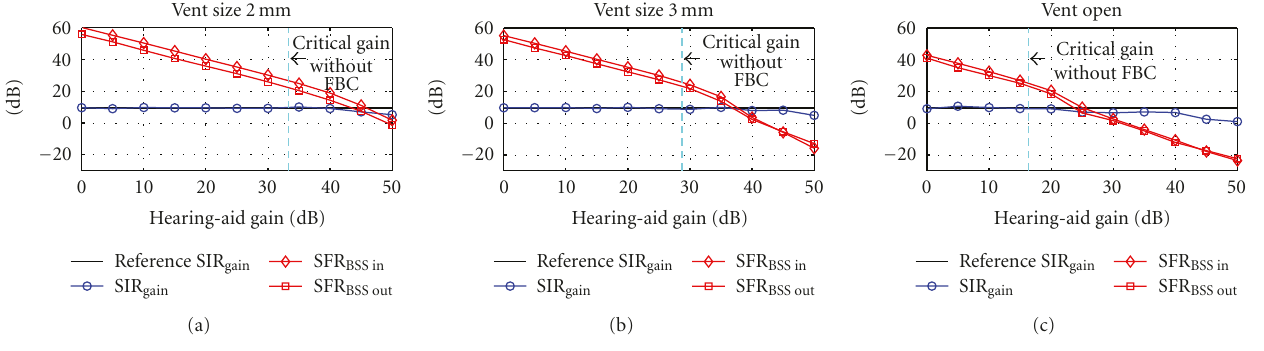
Figure 6: BSS performance for increasing HA gain, in a living-room environment.